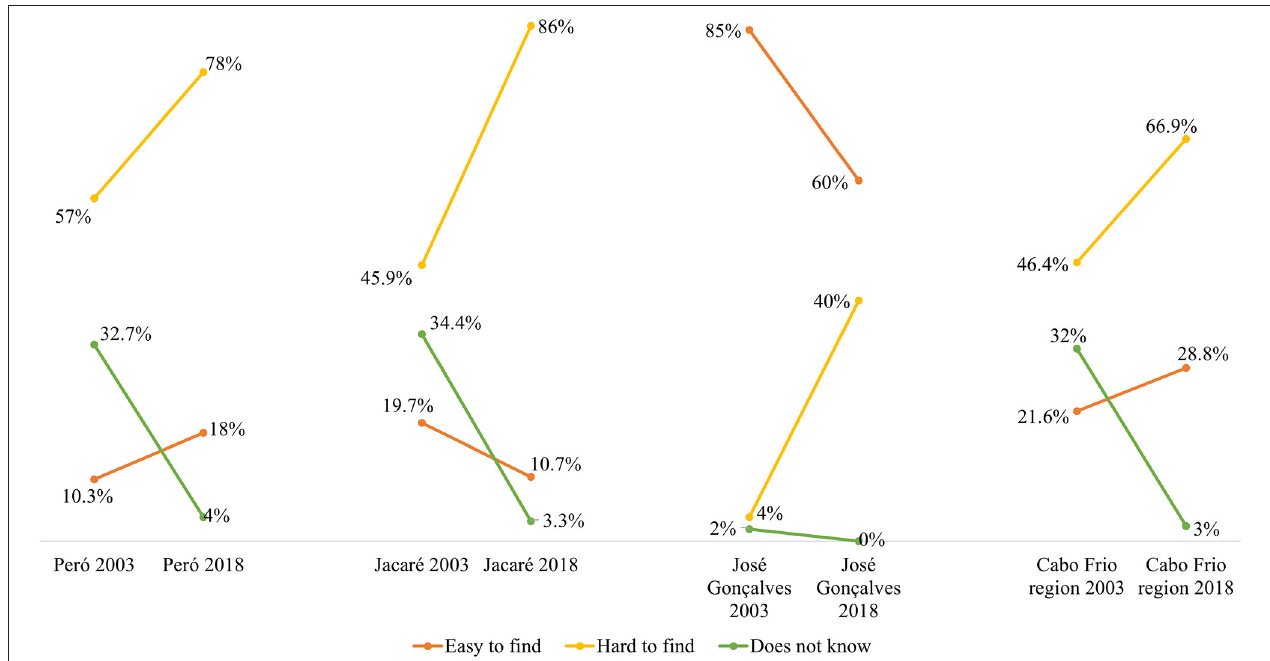
FIGURE 6 | Diachronic analysis comparing the changes in brazilwood abundance perception between Cabo Frio region residents over 15